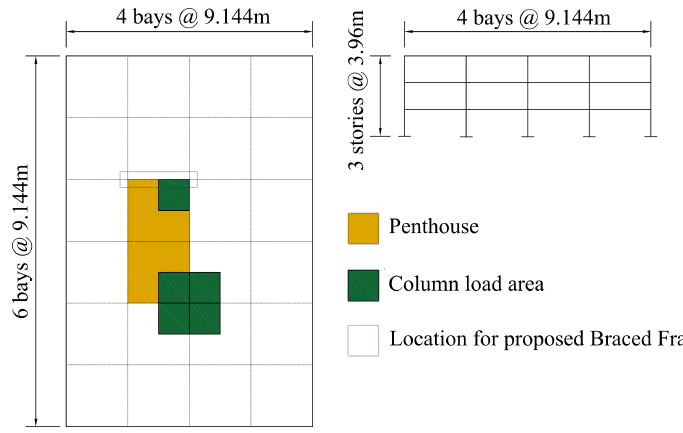
Figure 4. Floor plan and elevation view of the three-story SAC